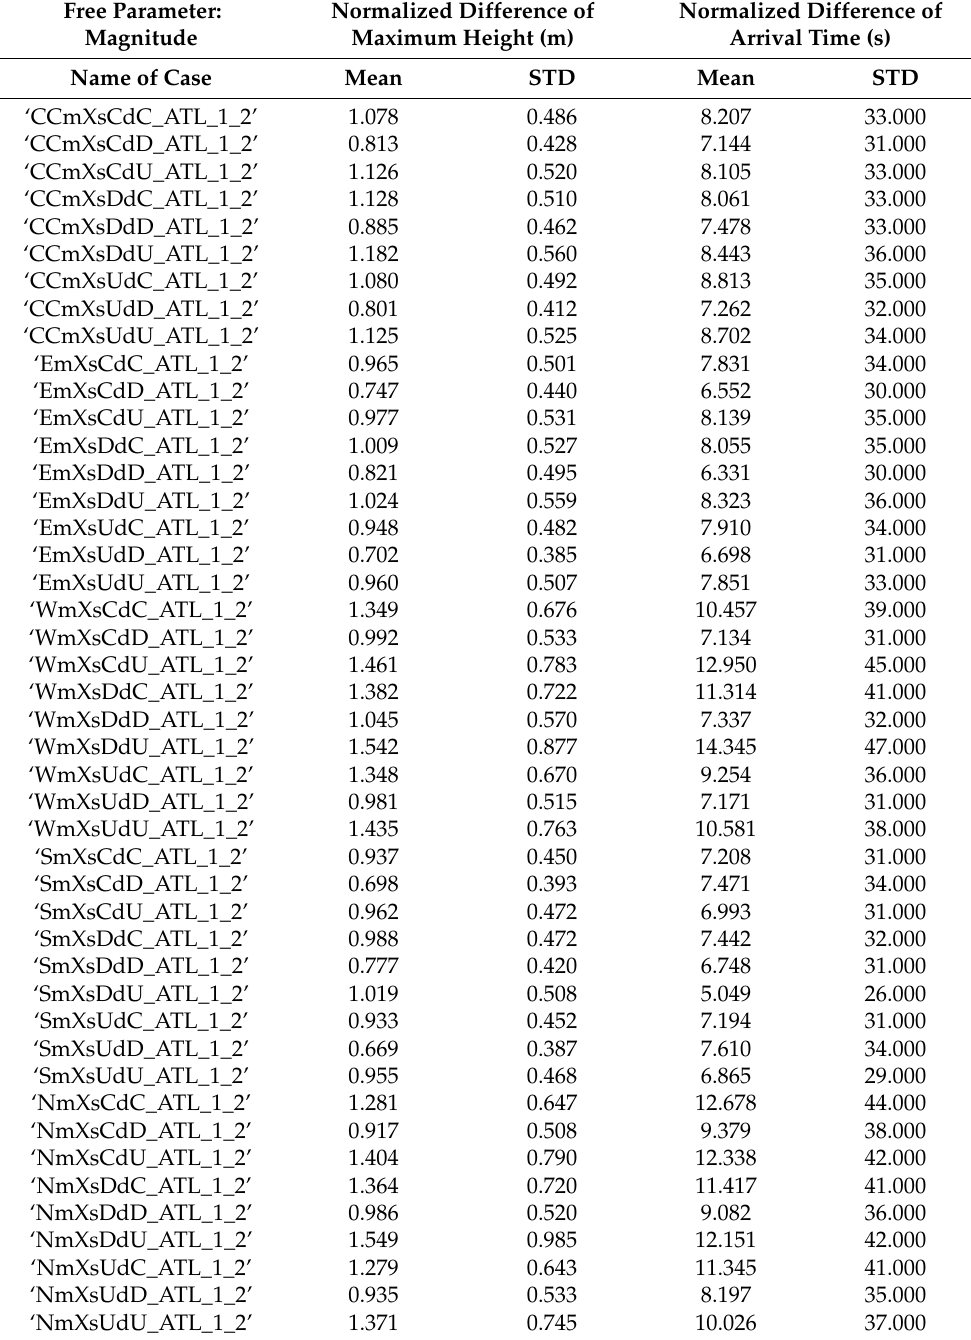
Table A4. Mean normalized difference of maximum height and arrival time for scenarios with varying